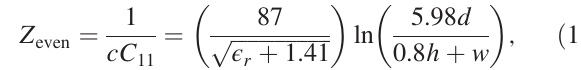
Fig. 4: all of them have a cylindrical beam pipe, since it is the easiest shape for manufacturing from a commer- cial pipe.